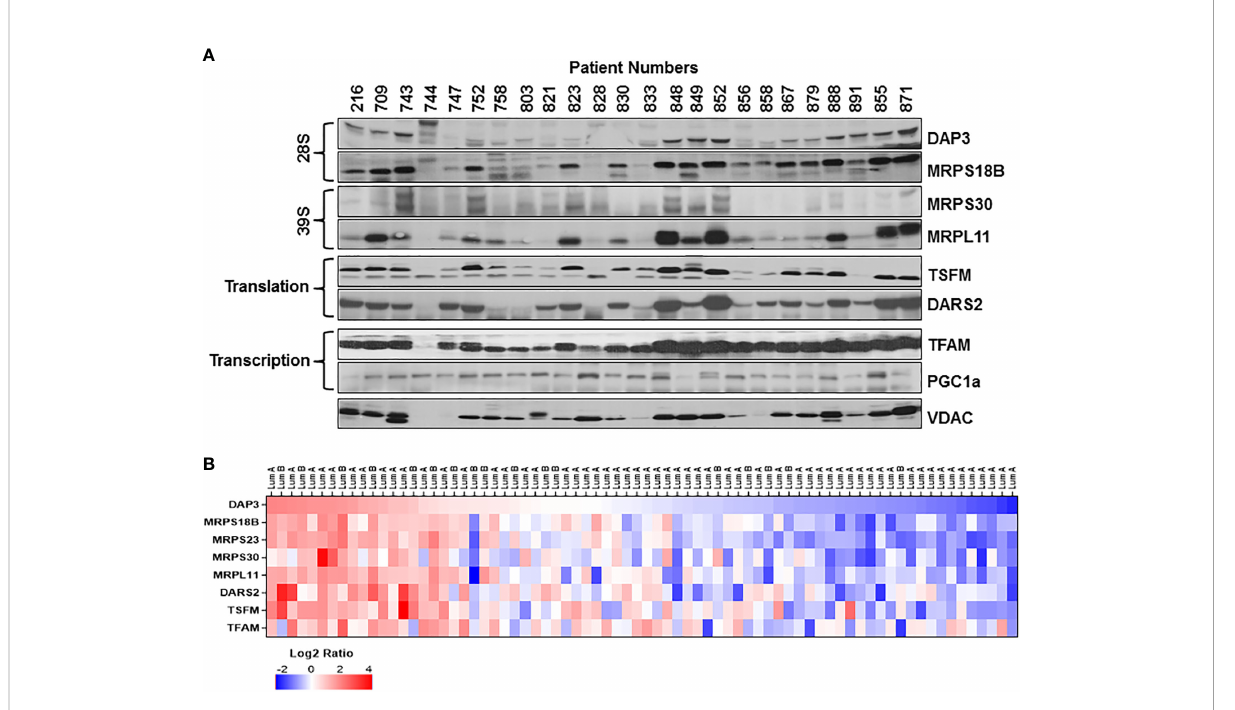
FIGURE 2 Mitochondrial translation and transcription related protein expression in ER/PR(+) breast cancer. (A) Relative expression of the mitochondrial small (28S) and large (39S) subunit proteins DAP3, MRPS18B, MRPS30, and MRPL11 were detected by immunoblotting analyses. TSFM and DARS2 are the two other mitochondrial translation related factors. Mitochondrial transcription related proteins, TFAM and PGC1a, as well as VDAC are also detected by immunoblotting of tumor lysates. Approximately 20 m g of lysates were separated by 12% SDS-PAGE and equal protein loading was evaluated by probing membranes with Ponceau S staining and GAPDH (data not shown). (B) Expression of various MRPs in the CPTAC data (65) set as described in Figure 1D legend. DAP3 expression in luminal A and B breast tumors is ranked from high (red) to low (blue) expression to show the correlation between the MRPs and the translation related factors DARS2 and